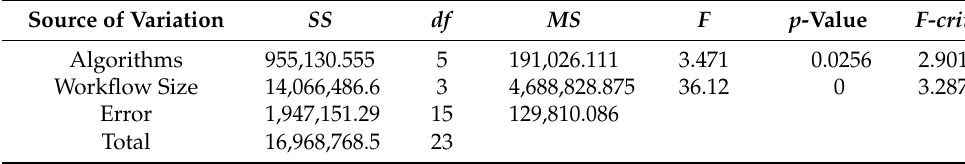
Table 15. Two way ANOVA descriptive results for SIPHT workflow.